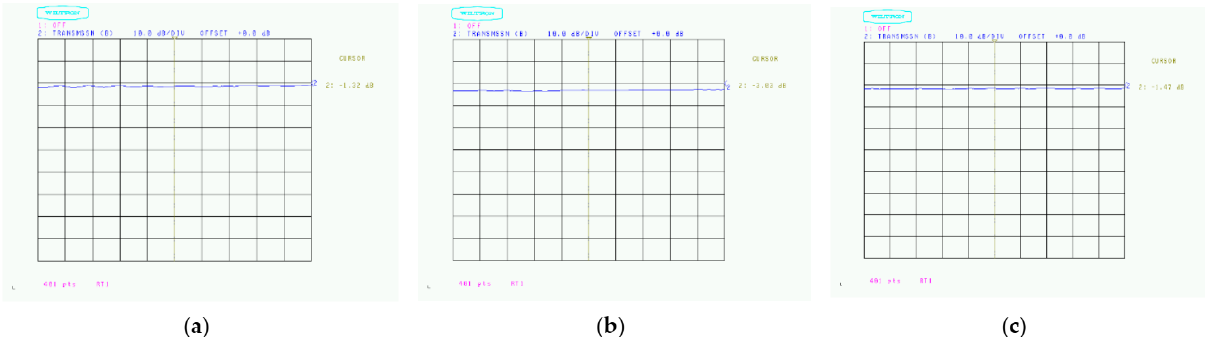
Figure 16. Radio wave absorption of CNT spray paint: ( a ) Coating thickness 16 µ m lower part (7.14 dB); ( b ) Coating thickness 35 µ m upper part (1.45 dB); ( c ) Coating thickness 75 µ m lower part (3.76 dB).